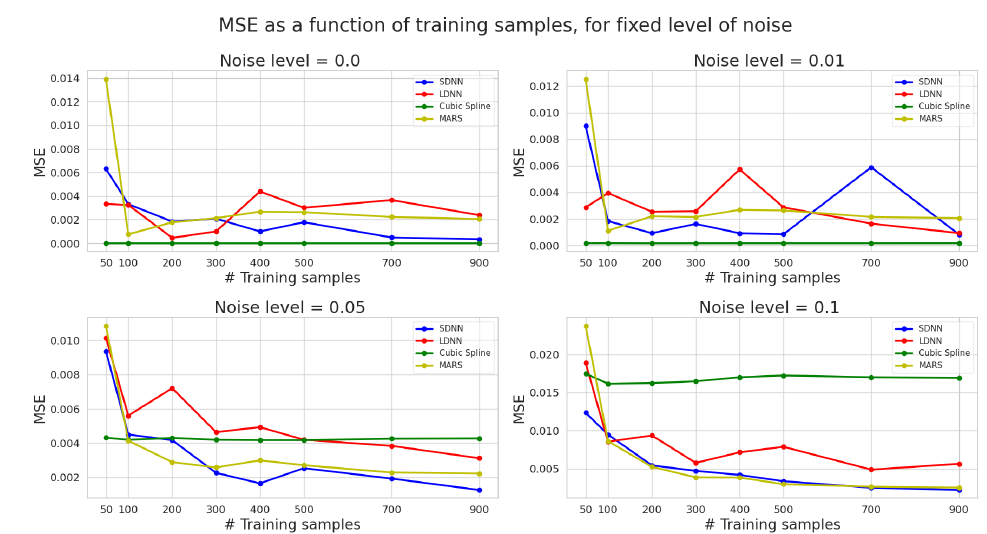
Figure 6. Test mean squared error vs. the total number of training samples for four different noise levels. The average values over five runs are presented. Blue represents SDNN, red LDNN, green cubic splines, and yellow